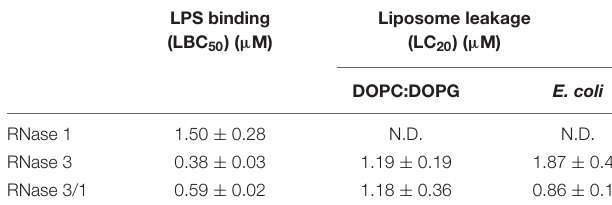
TABLE 2 | LPS-binding affinity and liposome leakage activity of RNases 1, 3 and